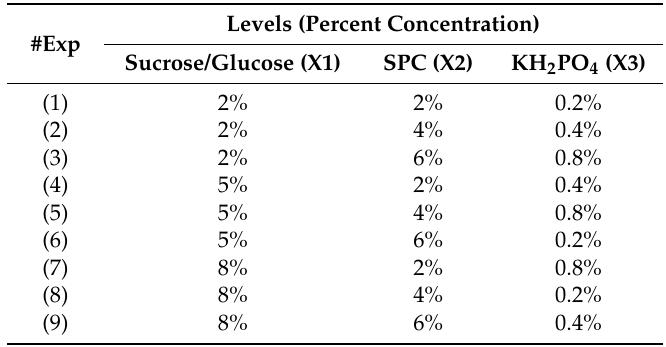
Table 1. L9 array for the design of media composition for all bacterial